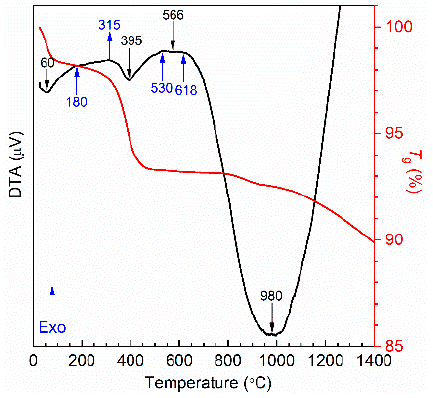
Figure 1. DTA/TGA thermograms of the obtained powders.